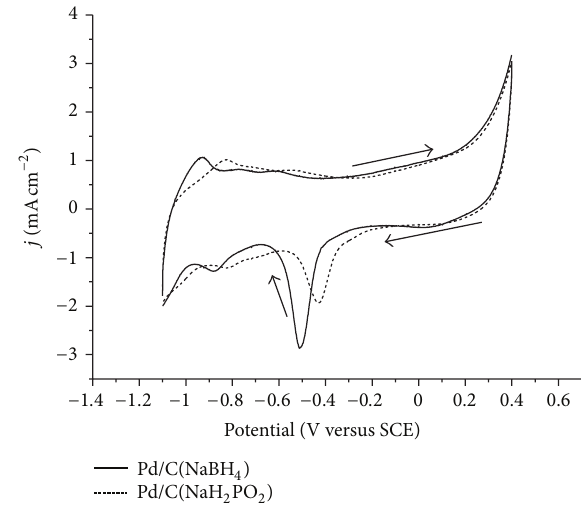
Figure 4: Voltammetric curves of Pd/C (NaBH 4 ) and Pd/C (NaH 2 PO 2 ) in 1mol ⋅ L −1 KOH